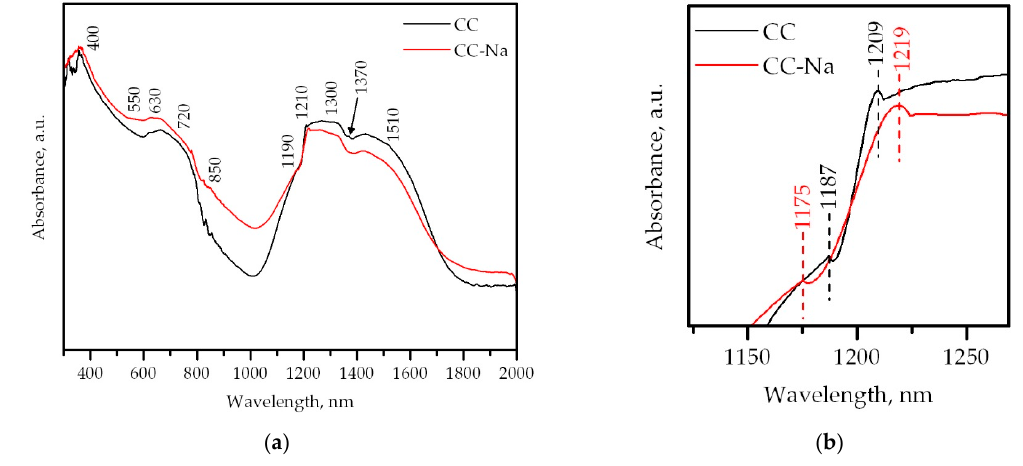
Figure 4. ( a ) UV-vis-NIR DRS spectra of the samples; ( b ) detail of the region around 1200 nm.